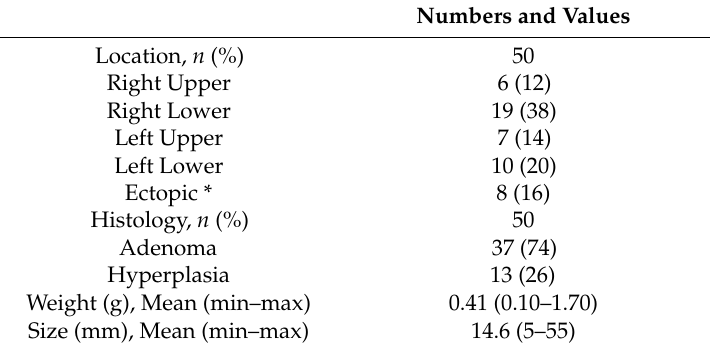
Table 2. Characteristics of hyperfunctioning parathyroids from 44 operated patients.